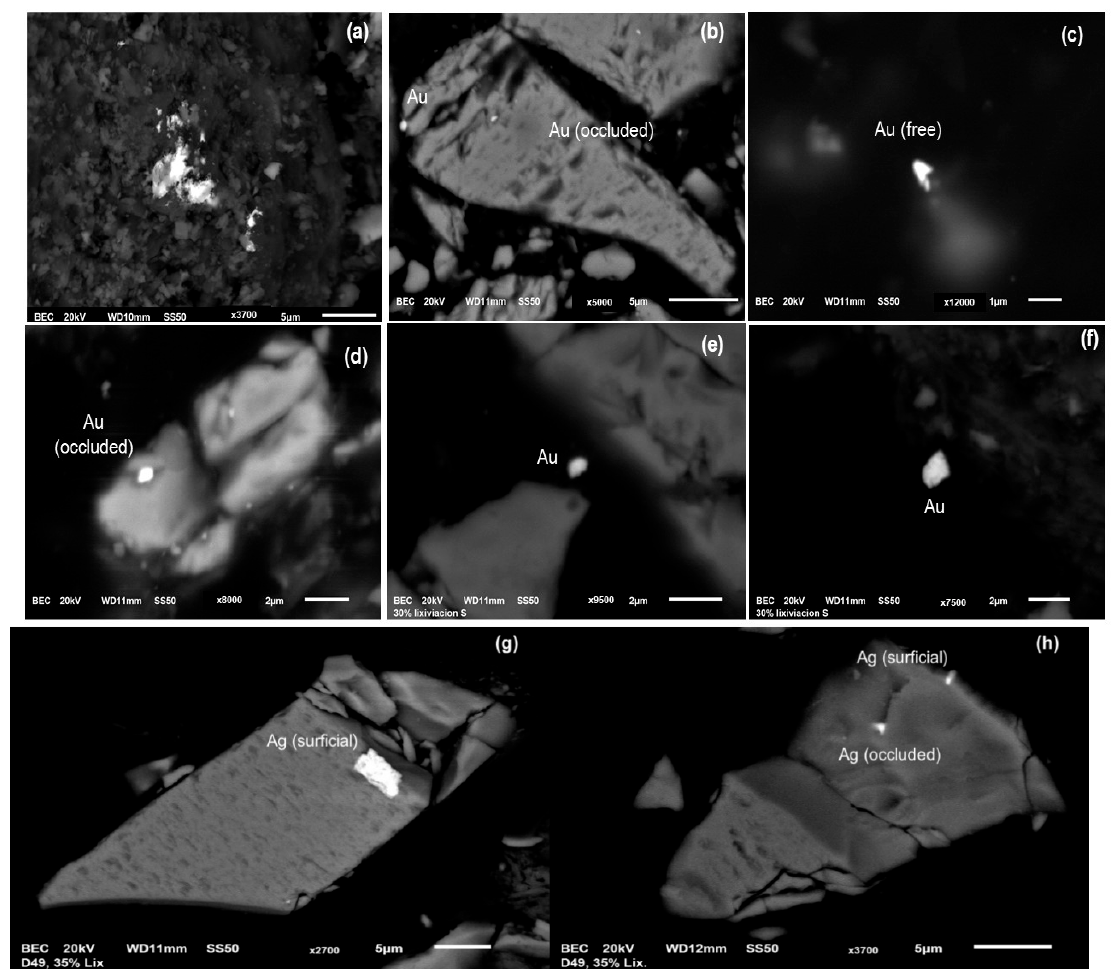
Figure 6. Images obtained by SEM of bio-oxidated FeS 2 particles after 14 ( a , b ), 21 ( c , d ), and 28 ( e , f ) days (previously preoxidized with bioferric flocculant at 30 ◦ C), in which the gold particles (Au) stand out. ( b ) FeS 2 with Au occlusions (<1 µ m), one at the edge ( left ) and the other within the particle ( center ); ( c ) Au in the free state; ( d ) Au entrapped in FeS 2 ; ( e , f ) Au in free state after 30% oxidation of the FeS 2 concentrate. ( g , h ) After 49 days of the assays, partially occluded Ag particles were observed with a size of 5 µ m ( g ) or less ( h ). For SEM-EDX analysis, samples were prepared by resin mounting with mirror-finish surface exposure. Table 4. Analyses and extraction of Au and Ag from the FeS 2 concentrate at the end of chemical–bacterial oxidation. Data show the maximum value reached after 72 to 96 h of agitation leaching using NaCN as the extractant.